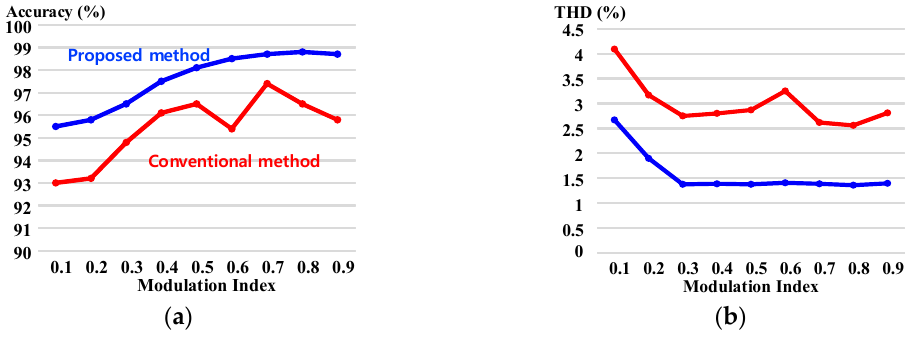
Figure 26. Comparison of the conventional and proposed methods according to the variation in the MI. ( a ) Phase current Accuracy; ( b ) total harmonic distortion (THD) of phase currents.